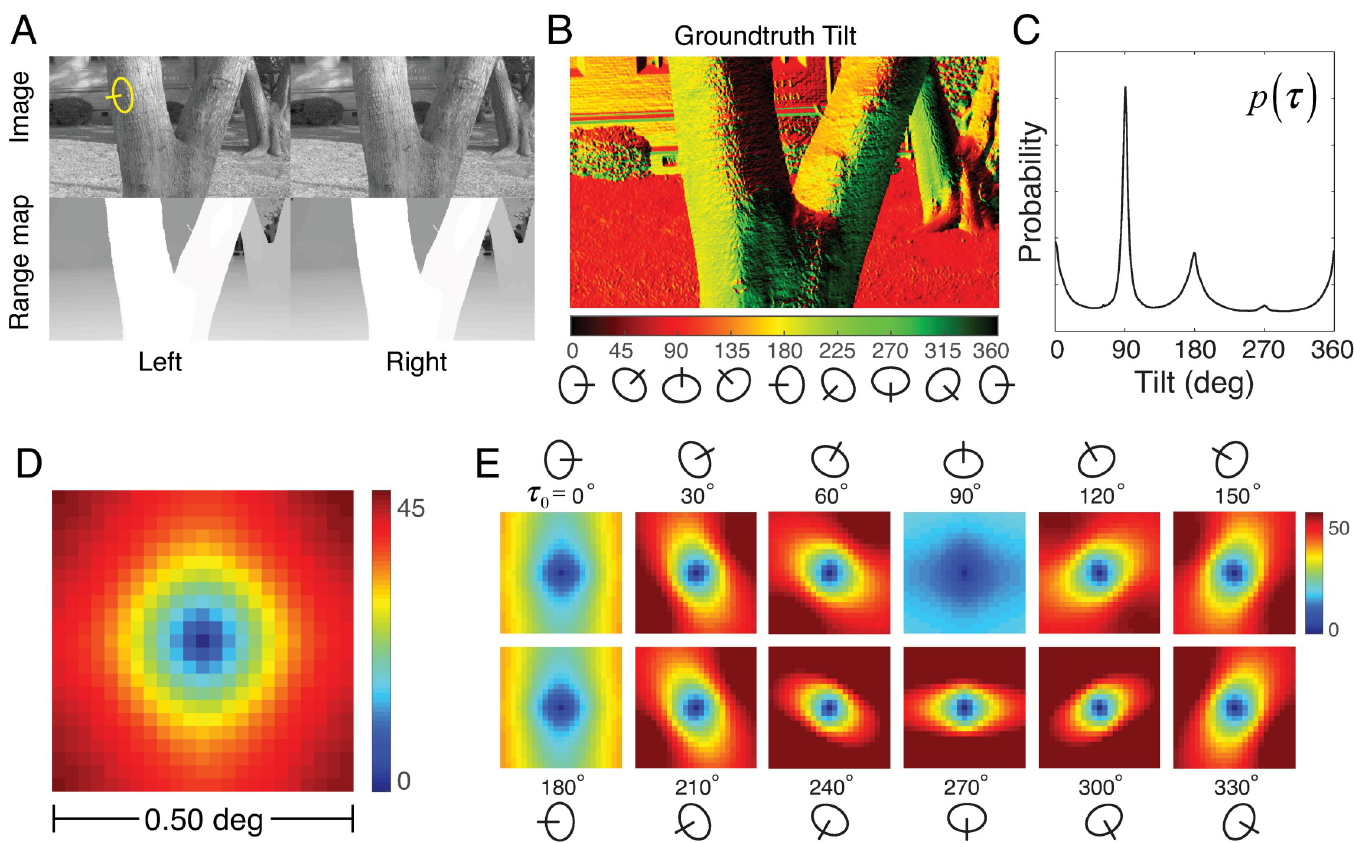
Fig 2. Spatial statistics of tilt in natural scenes. A Stereo images and stereo distance maps of real-world scenes. The distance data is co-registered to the image data at each pixel. B Groundtruth tilt corresponding to the image in A. Groundtruth tilt at each pixel is computed directly from the data in the distance maps. C Prior distribution of groundtruth tilt, computed from 600 million groundtruth tilt samples in the natural scene database. D Mean absolute tilt difference from the center target tilt as a function of spatial location. The color represents the tilt difference across all pixels in all images in the natural scene database. E Mean absolute tilt difference conditioned on the groundtruth tilt at the target